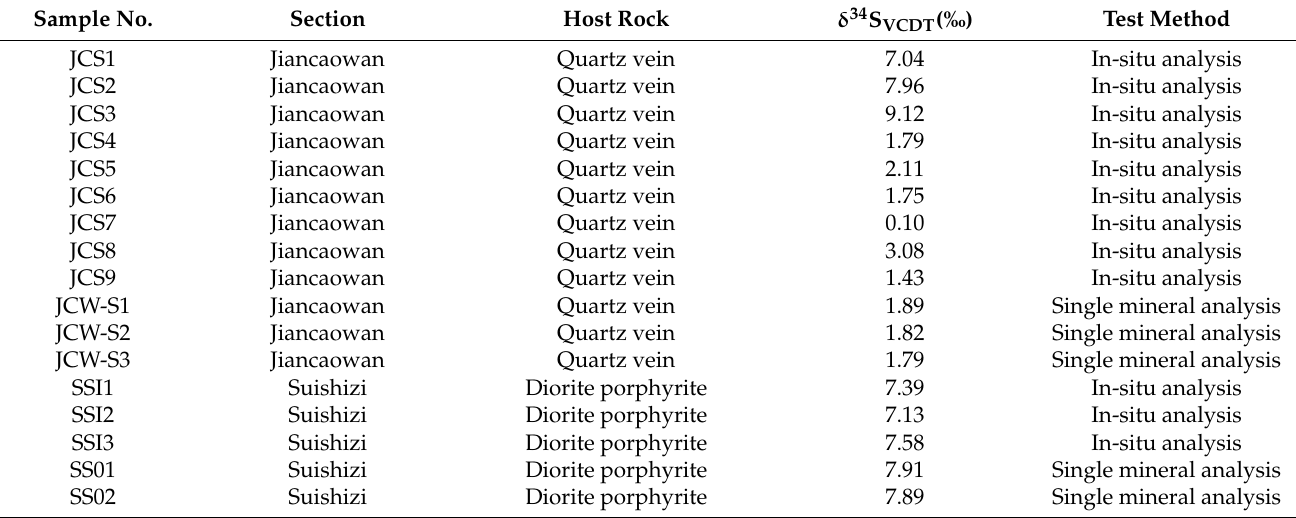
Table 2. Single mineral and in situ sulfur isotope of pyrite from Liziyuan gold